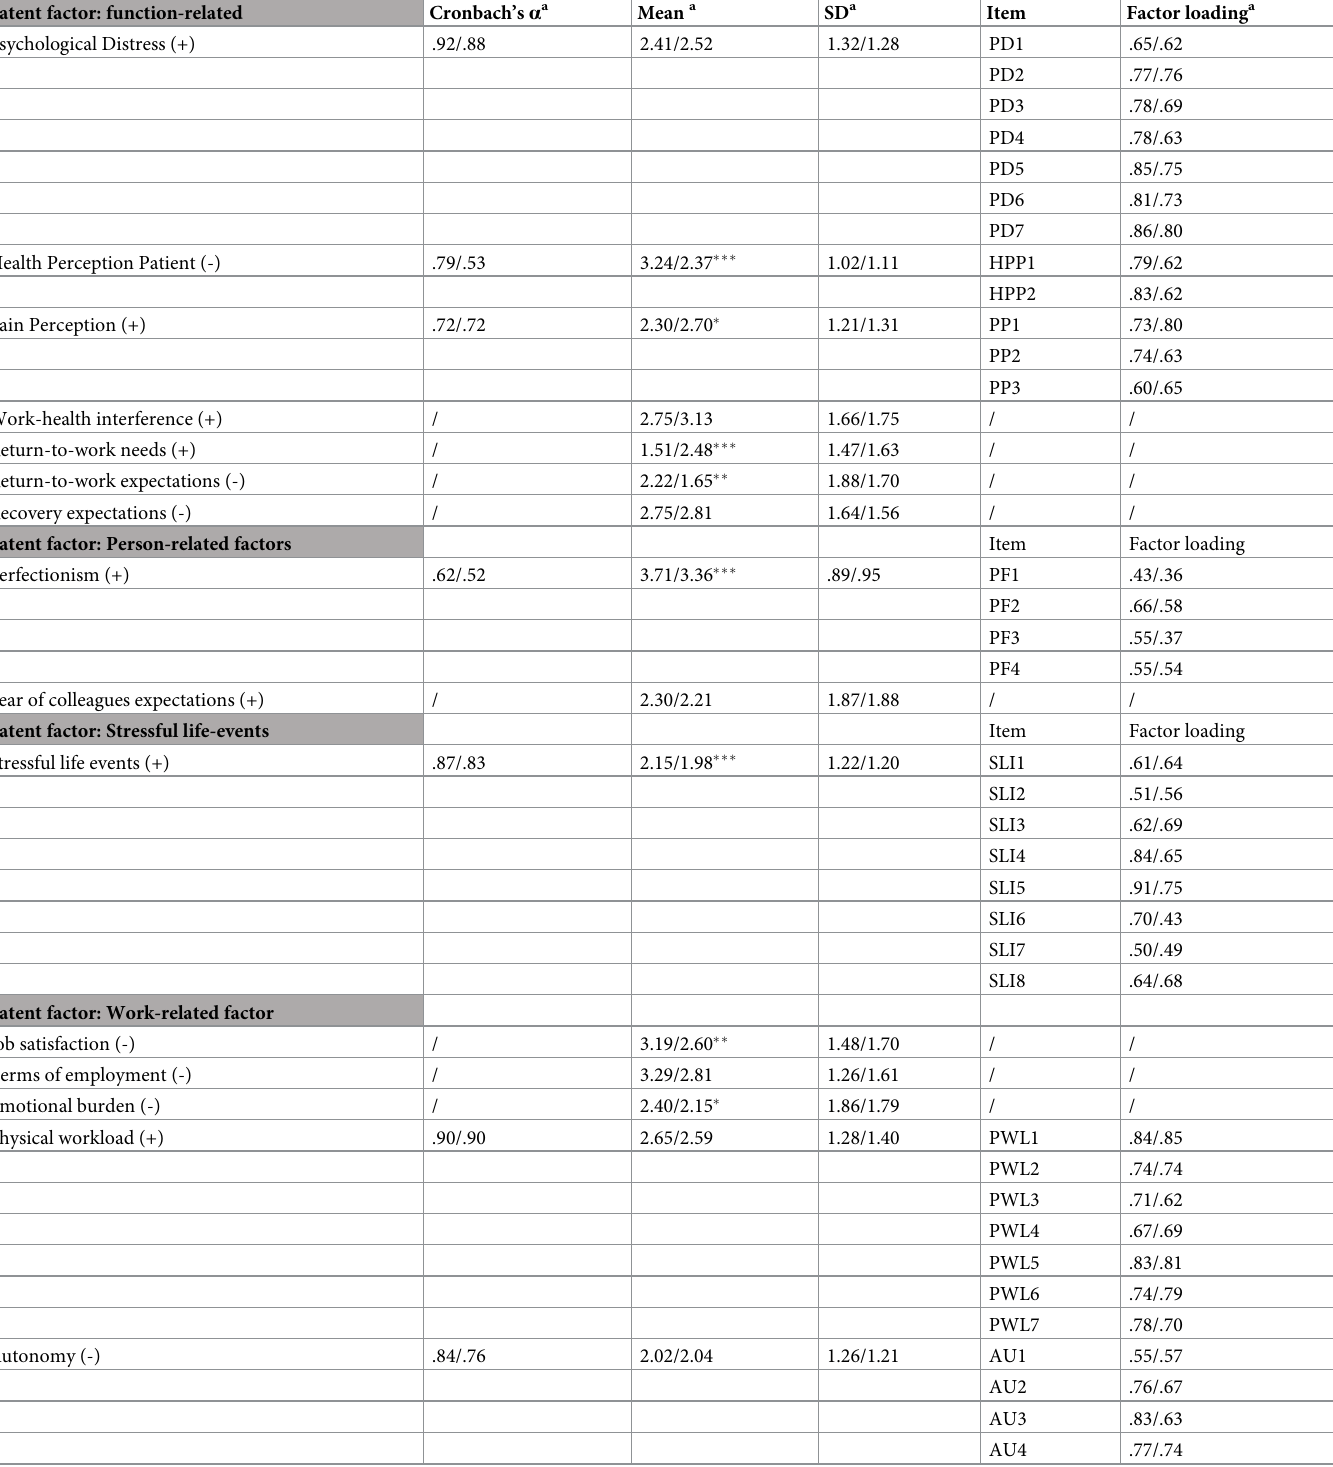
Table 2. Descriptive statistics (means, standard deviations) and results for reliability tests (Cronbach’s alpha) and confirmatory factor analysis for the different Quickscan scales for sample 1 (n = 3540) and sample 2 (n =